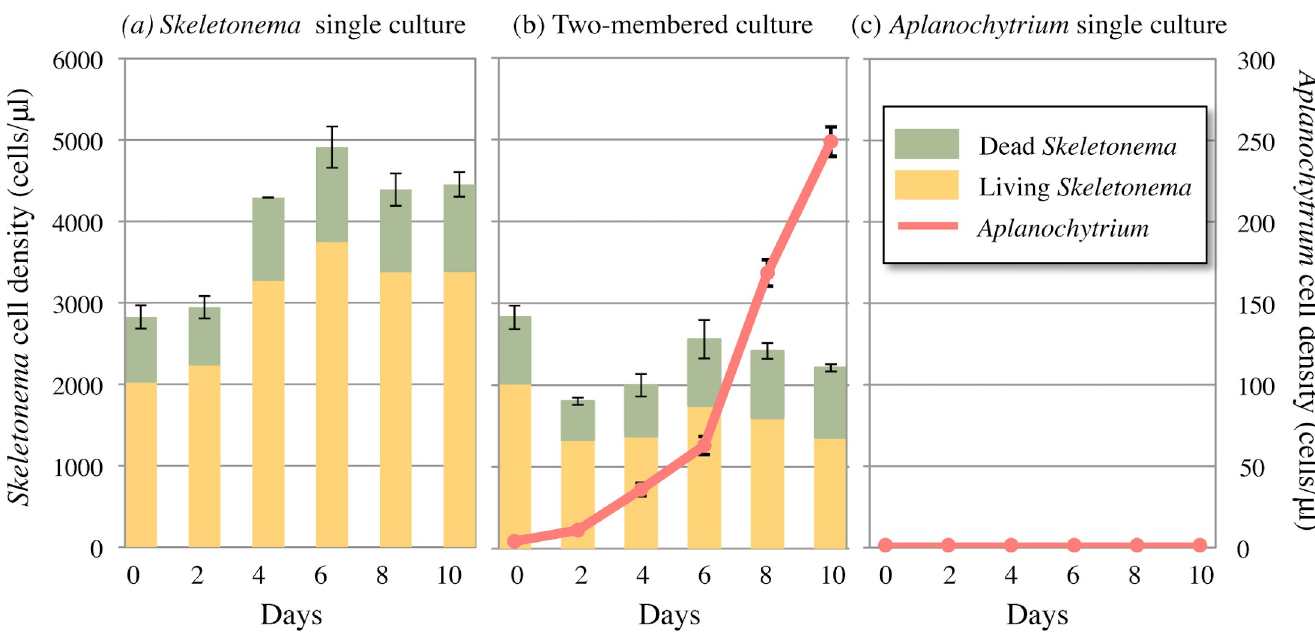
Fig 7. Growth of Aplanochytrium and Skeletonema in a single- and two-membered cultures. (a) Numbers of living (yellow) and dead (green) Skeletonema cells in a single culture. (b) Numbers of living (yellow) and dead (green) Skeletonema cells and Aplanochytrium kerguelense (KMPB N-BA-107) cells (red line) in two- membered culture. (c) Numbers of Aplanochytrium cells (red line) in a single culture.